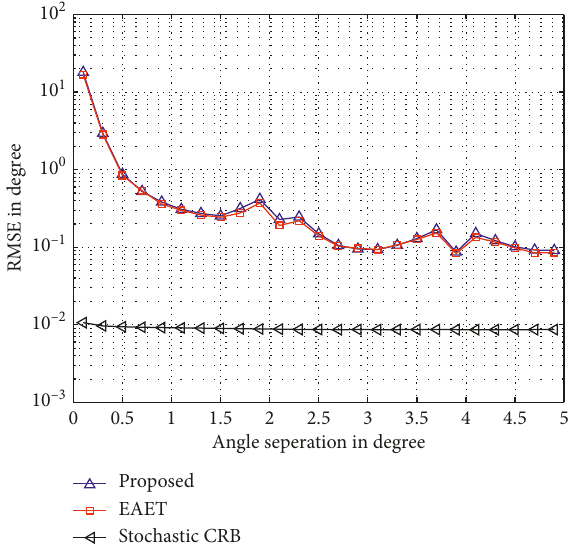
Figure 5: The RMSE of azimuth estimation vs. azimuth separations.